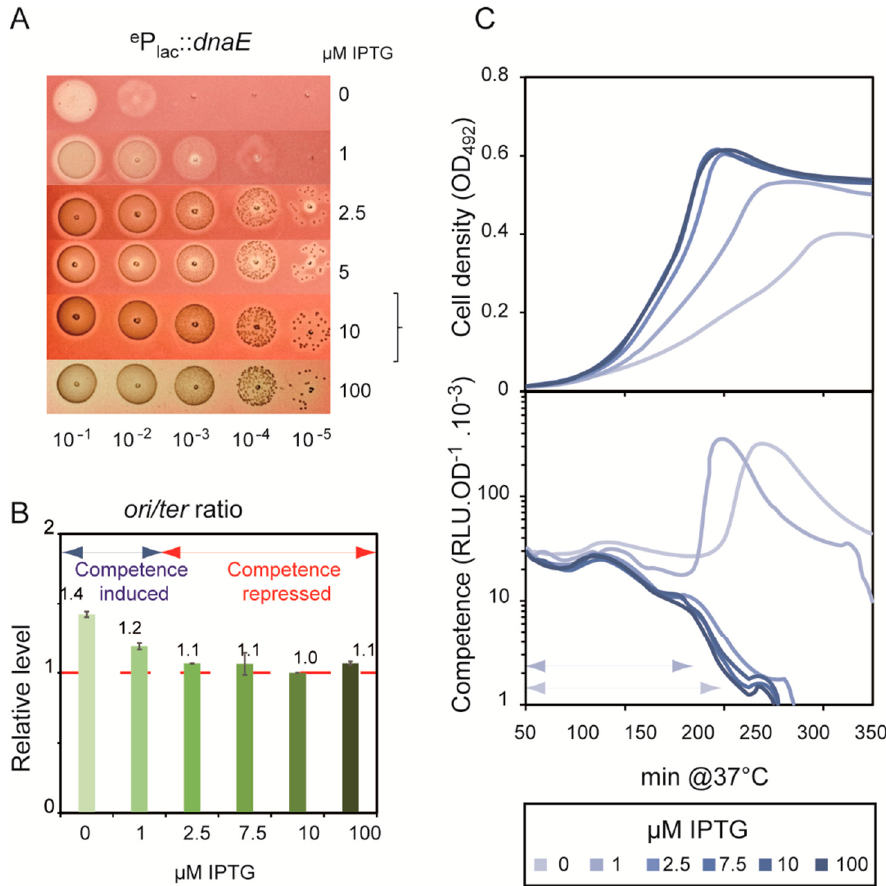
Figure 5. Reduction of dnaE expression induces competence. In strain R3315, the endogenous dnaE promoter has been replaced by the inducible P lac promoter ( e P lac :: dnaE , see Section 2). ( A ): Growth assay. R3315 cells were grown to OD 550 = 0.3 and then diluted and spotted on medium containing the indicated IPTG concentrations. The bracket covers IPTG concentrations enabling the mutant to mimic wt growth. ( B ): ori / ter ratios measured by qPCR on total DNA extracted from the R3315 strain ( e P lac :: dnaE ) cultivated at the indicated IPTG concentrations. The ori / ter ratio obtained for cells grown with 10 µ M IPTG was used as the reference ratio to calculate the relative level (y-axis); it corresponds to the ori / ter ratio of the isogenic WT strain (red horizontal dotted line). The relative ori / ter ratio at each IPTG concentration is indicated, with standard deviations: values are the means of two replicates. The competence development status of each assay is indicated by the blue (induced) and red (repressed) double arrows. ( C ): Competence expression of the ssbB::luc transcriptional fusion in R3315 was monitored in C+Y medium adjusted at an initial pH non permissive for competence development when cells are cultivated with 10 µ M IPTG, which fully complemented growth as WT cells. Curves represent the mean of four replicates for each growth condition performed at the indicated IPTG values. Standard deviations are omitted for clarity. Double arrowheads specify the X A period.